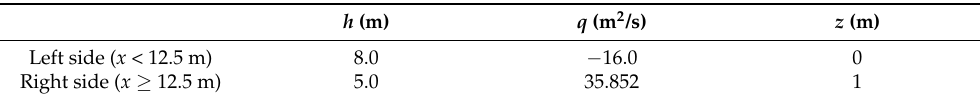
Table 4. Initial conditions for two rarefaction waves propagating over a step.